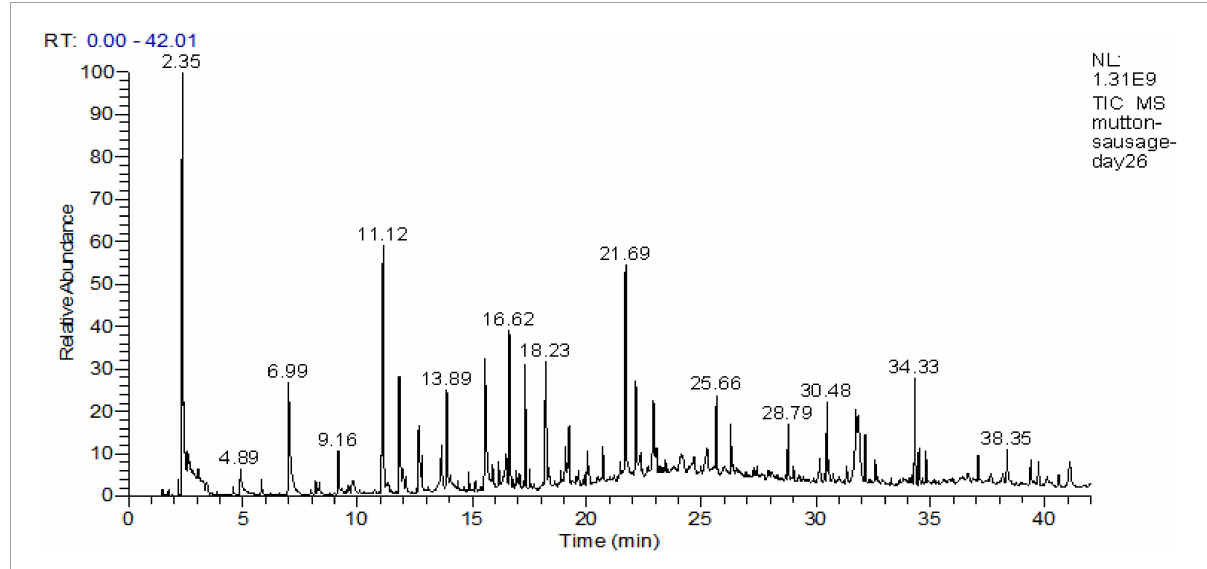
FIGURE6 Total ion current chromatogram of fermented mutton sausage on day